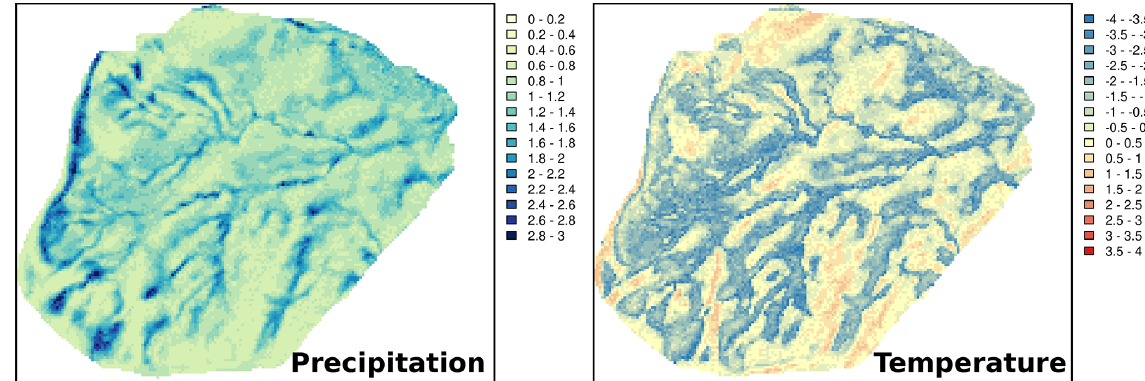
Figure 6. Posterior perturbation parameters for the precipitation [non-dimensional] (multiplicative) and temperature [K] (additive).